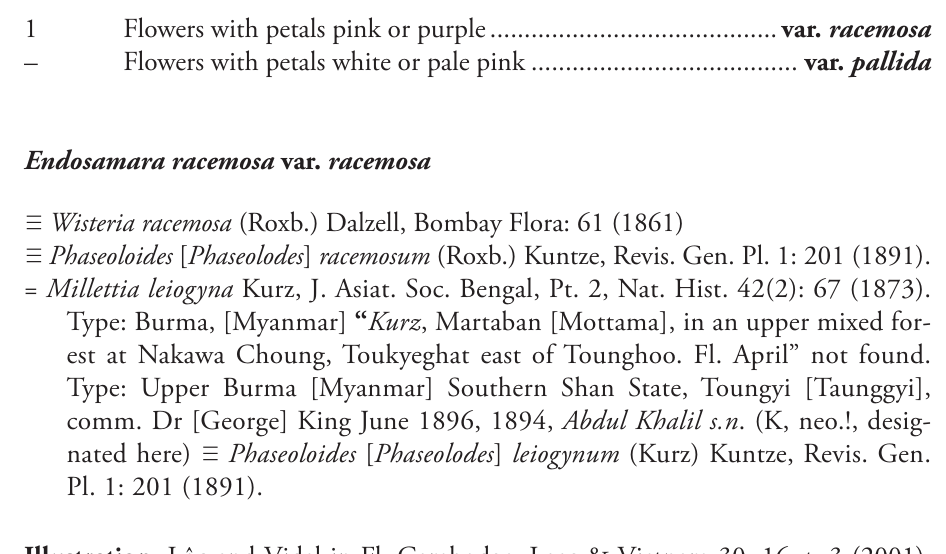
Endosamara racemosa var.